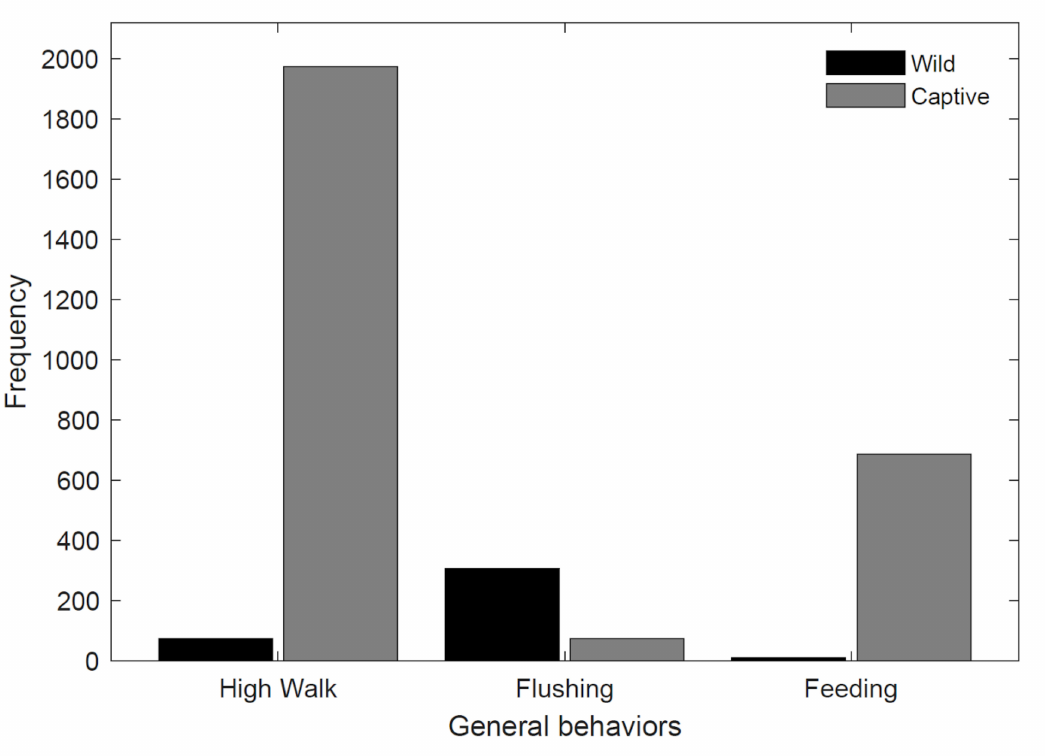
Figure 6. The frequency of the three most commonly observed general behaviors compared between the captive and wild congregations. Feeding opportunities in the captive congregation are regulated by